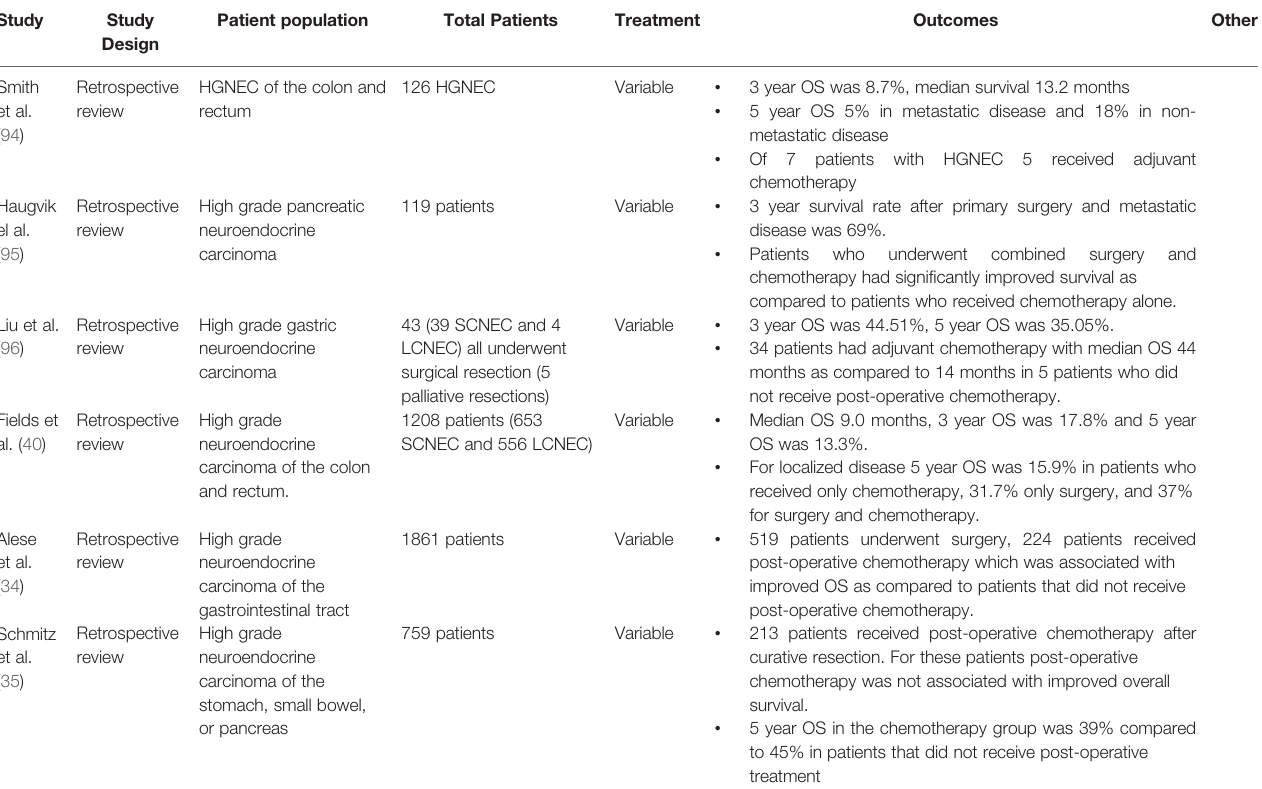
TABLE 6 | Adjuvant therapy extra-pulmonary LCNEC (most studies report outcomes for combined SCNEC and LCNEC patient populations). Study Study